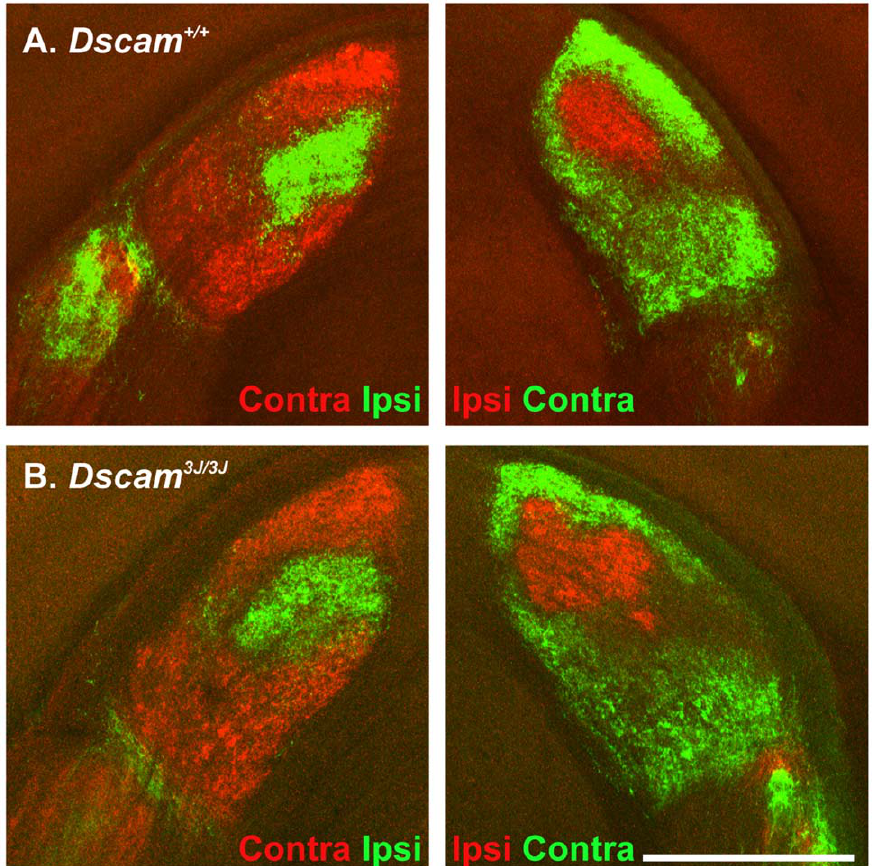
Figure 4. Normal LGN refinement in Dscam 3J mutant. Cholera toxin labeled with alexa-488 or cy3 was injected into the right (cy3) or left (488) eyes of wild type and Dscam 3J mutant mice to assay refinement of axonal projections. Both ipsilateral and contralateral projections of Dscam 3J mutant mice were similar to wild type. The scale bar in (B) is equivalent to 225 m m.